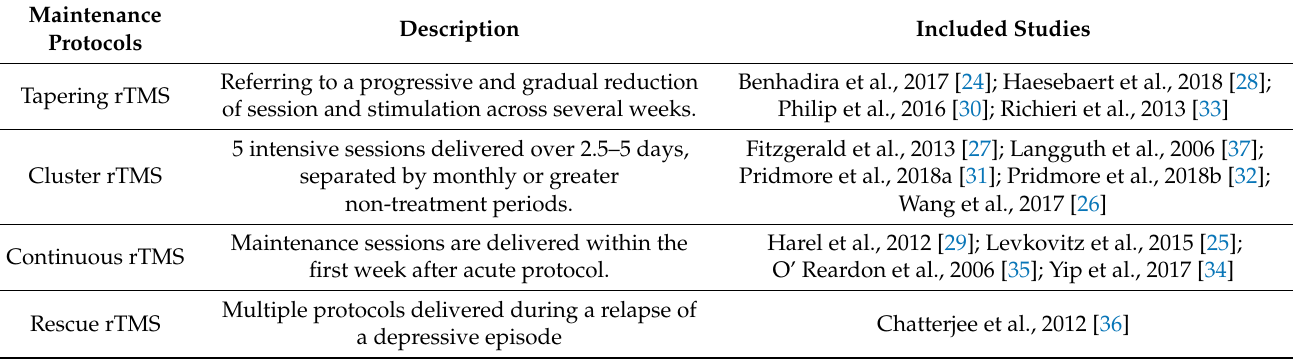
Table 3. Type of Maintenance